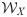
Imbalanced amplification and suppression reverse the blurring introduced by interlaminar synaptic divergence.a) A disc-shaped grating stimulus gives rise to b) a disc-shaped firing rate profile, rX(x), in L4 with slightly blurred edges (achieved by convolving contrast from a with a Gaussian kernel). c) Input, XE(x), from L4 to excitatory neurons in L2/3 is blurred by synaptic divergence, which effectively applies a low-pass filter, WX, to the L4 rates. d) Excitatory firing rates in L2/3 are sharper than external input when lateral excitation is similar, but smaller, in width than interlaminar excitation (αE = 0.85αX). e) Same as c, but lateral excitation is exactly as broad as interlaminar excitation (αE = αX), which sharpens the edges further, making firing rates in L2/3 similar to those in L4. f) Same as c, but lateral excitation is broader than interlaminar excitation (αE = 1.1αX), which sharpens the edges even further, but also introduced suppressed regions due to Gibbs phenomena. g-l) Same as a-f, but contrast was determined by the brightness of a photograph. Horizontal and vertical axes are neurons’ receptive fields.